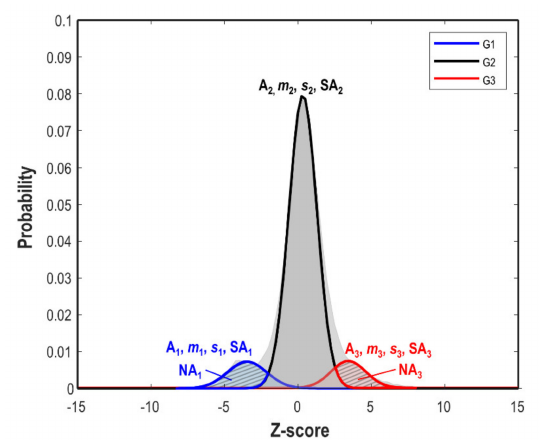
Figure A1. Tri-model Gaussian distribution. Mode 1 ( G 1 ) and Mode 3 ( G 3 ) are for the changes with decreased and increased Z-score values, whereas Mode 2 ( G 2 ) is for the unchanged class. SA is surface area under the colored curve. NA is the non-overlapping area, marked by slash